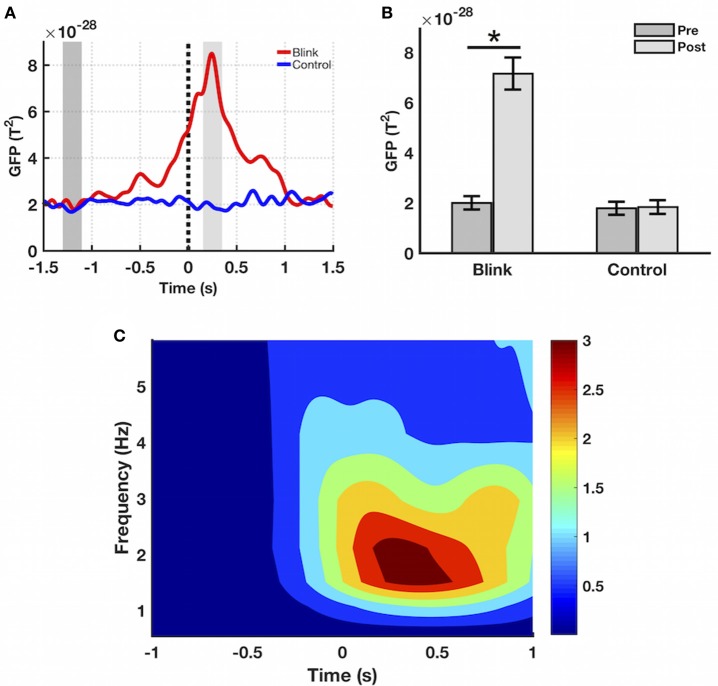
Sensor-level results. (A) Grand averaged GFP waveform in the delta band. GFP amplitude peaks at ~250 ms latency in the blink condition, not seen in control. Black dotted line denotes T0. Dark and light gray shaded regions represent windows of interest in the pre and post intervals, respectively. (B) Mean GFP over the windows of interest highlighted in part (A), calculated for each subject and presented as mean ± SE over all subjects. *p < 0.001. (C) Event-related spectral power in the blink condition, presented as mean over all channels. Delta band spectral power increases in the post-blink interval compared to pre-blink, peaking at ~250 ms latency (p < 0.05). Color bar represents power values.